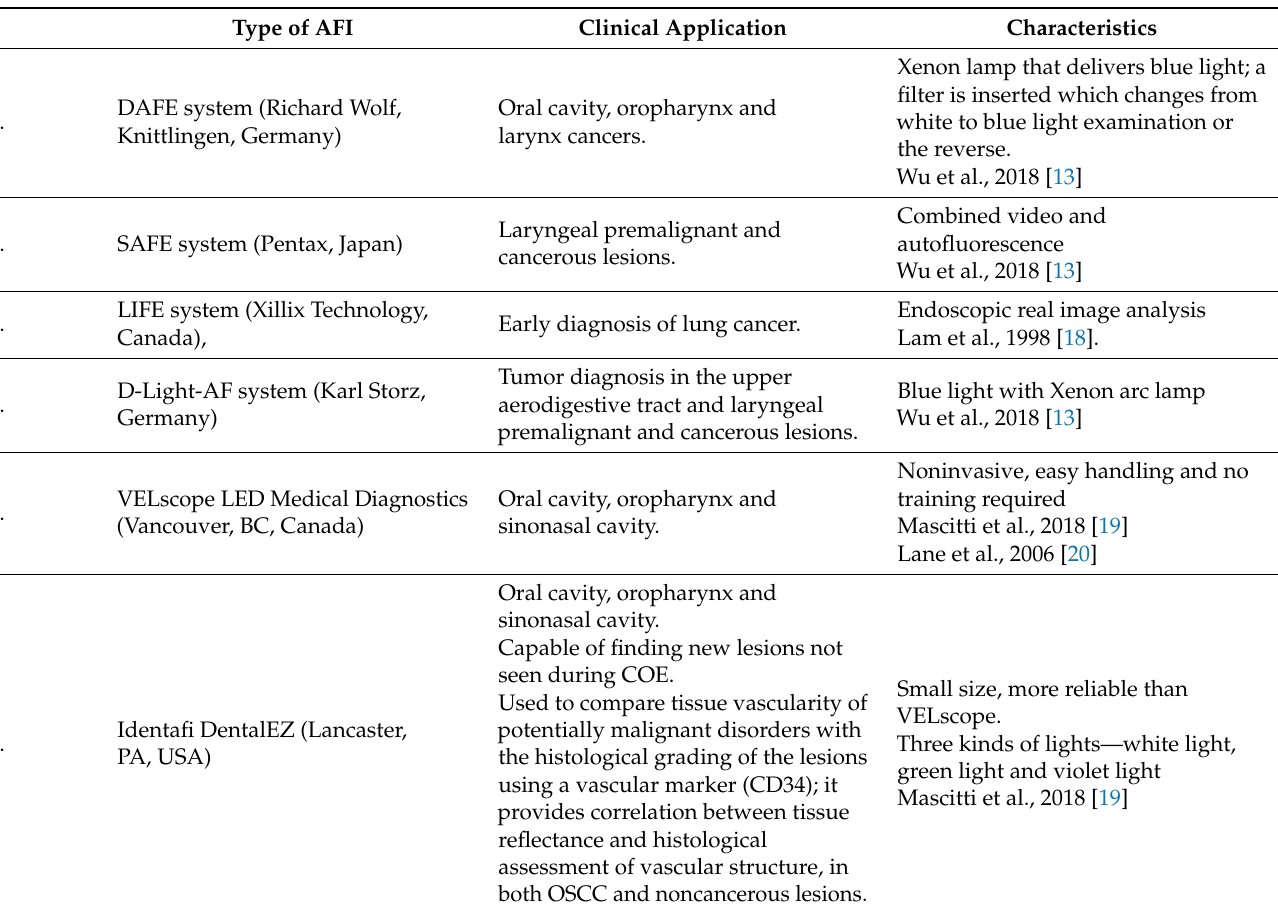
Types of Autofluorescence imaging techniques (AFI) that used in diseases and tumor